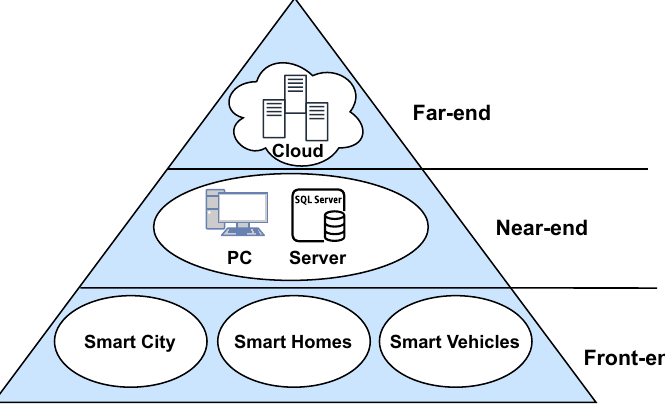
Figure 2. Architecture of Edge